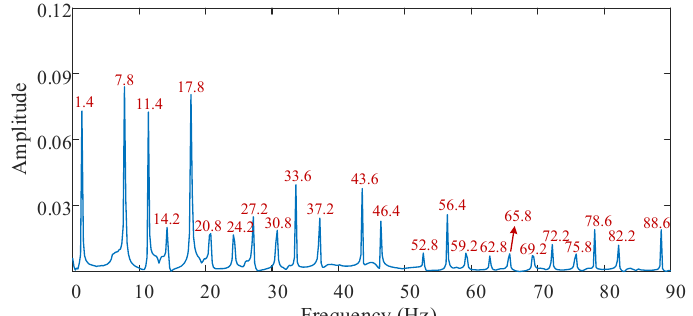
Figure 5. Spectrum diagram of the circulating current of phase A obtained by the multi-loop method.